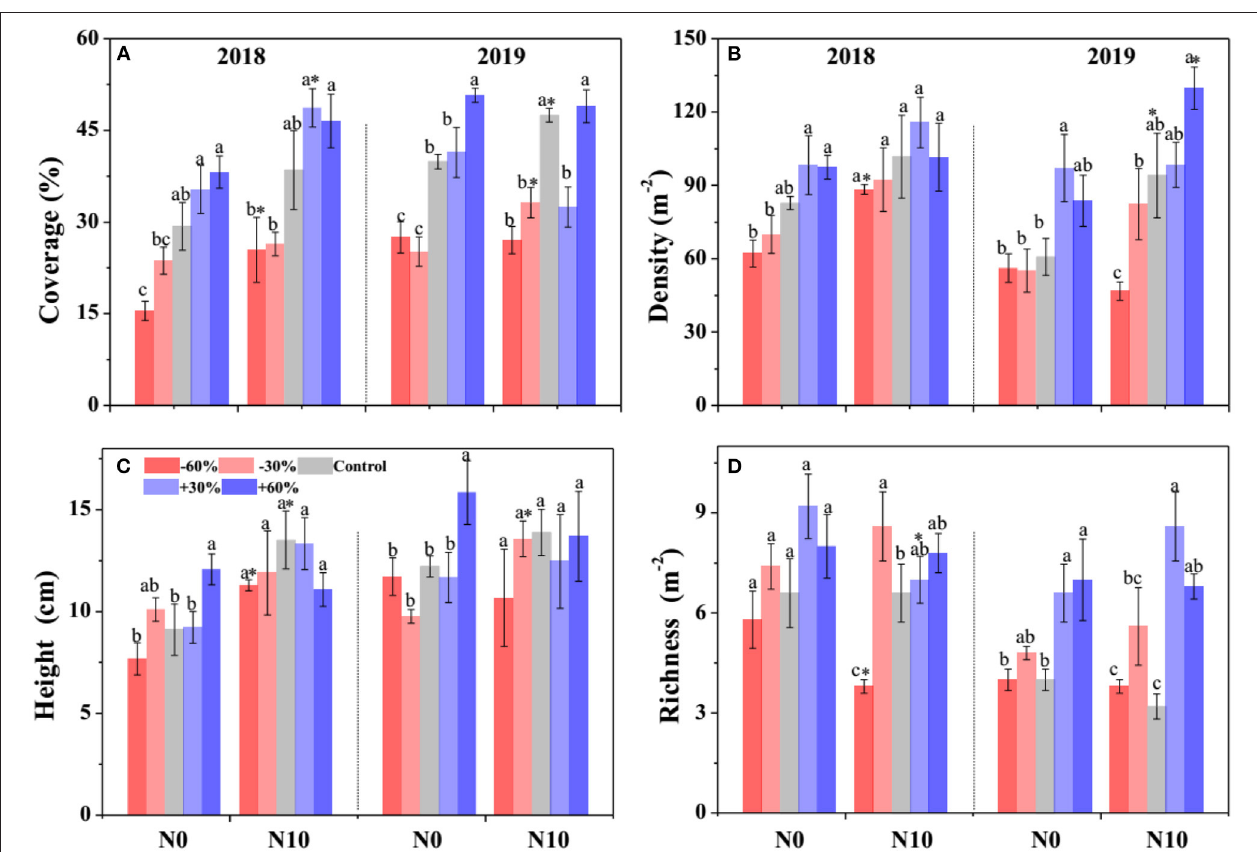
FIGURE 2 | Effects of precipitation change and nitrogen application on community attributes (A–D) in 2018 and 2019. Bars are represented as mean ± 1 SE. Different lowercase letters indicate significant differences ( P < 0.05) between precipitation treatment groups. *Indicates significant differences ( P < 0.05) between the N0 and N10 treatments. The precipitation treatments include five levels, namely, − 60%, − 30%, Control, + 30%, and + 60% precipitation relative to the ambient level. N0 and N10 represent the treatments without N addition (Control) and with 10g N m − 2 yr − 1 application of nitrogen,